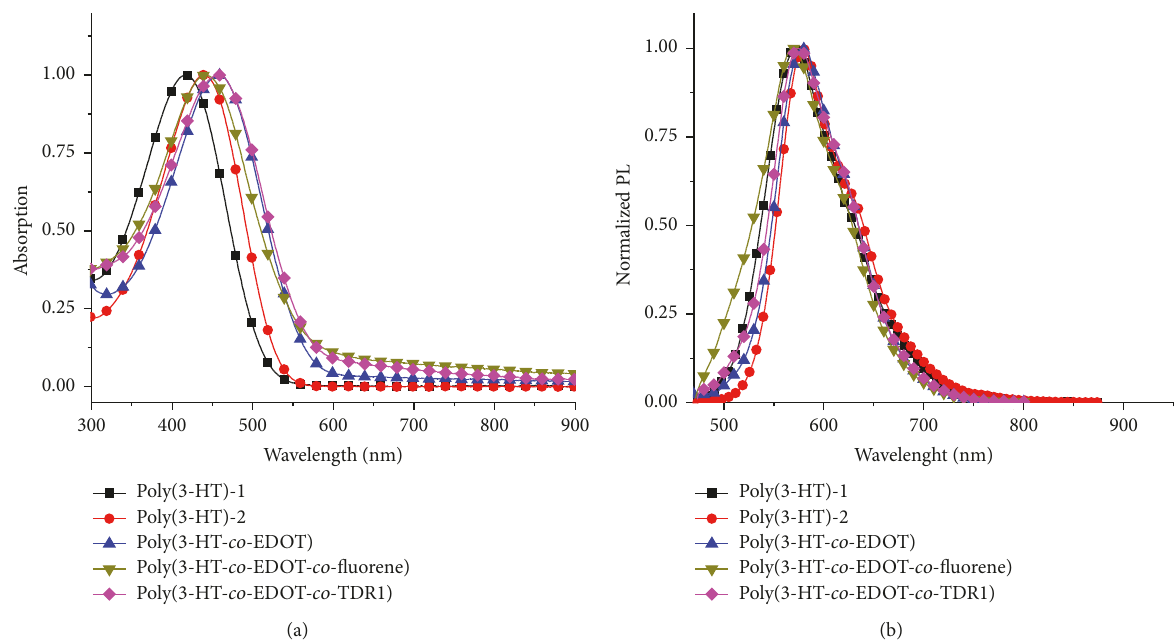
Figure 5: (a) Absorption and (b) emission spectra of the polymers. The emission spectra were obtained under UV excitation at 365 nm.